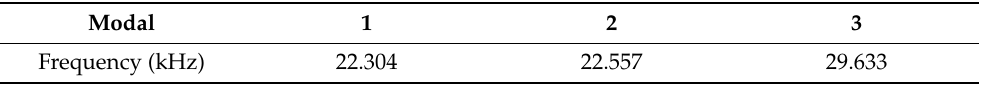
Table 3. The resonant frequency of the microdissection device with a flexure mechanism.